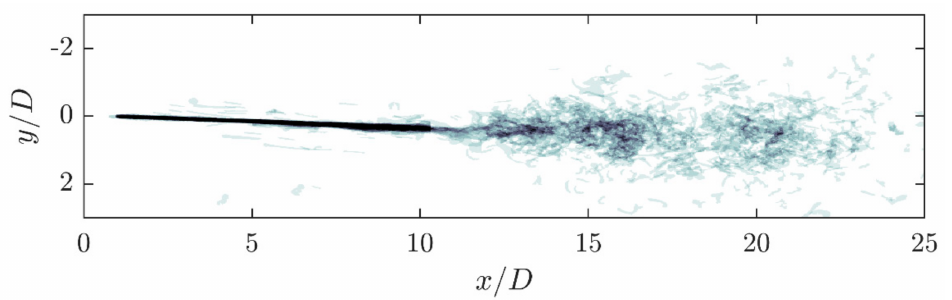
Figure 16. Superposition in the wake area of the orifice in the test facility scaled to scale 5 (M5) of the droplets added on the axis of symmetry (r ∗ = 0) in front of the orifice at Re = 2000. Only deformed droplets are shown. It is clear that most of the droplets exit the